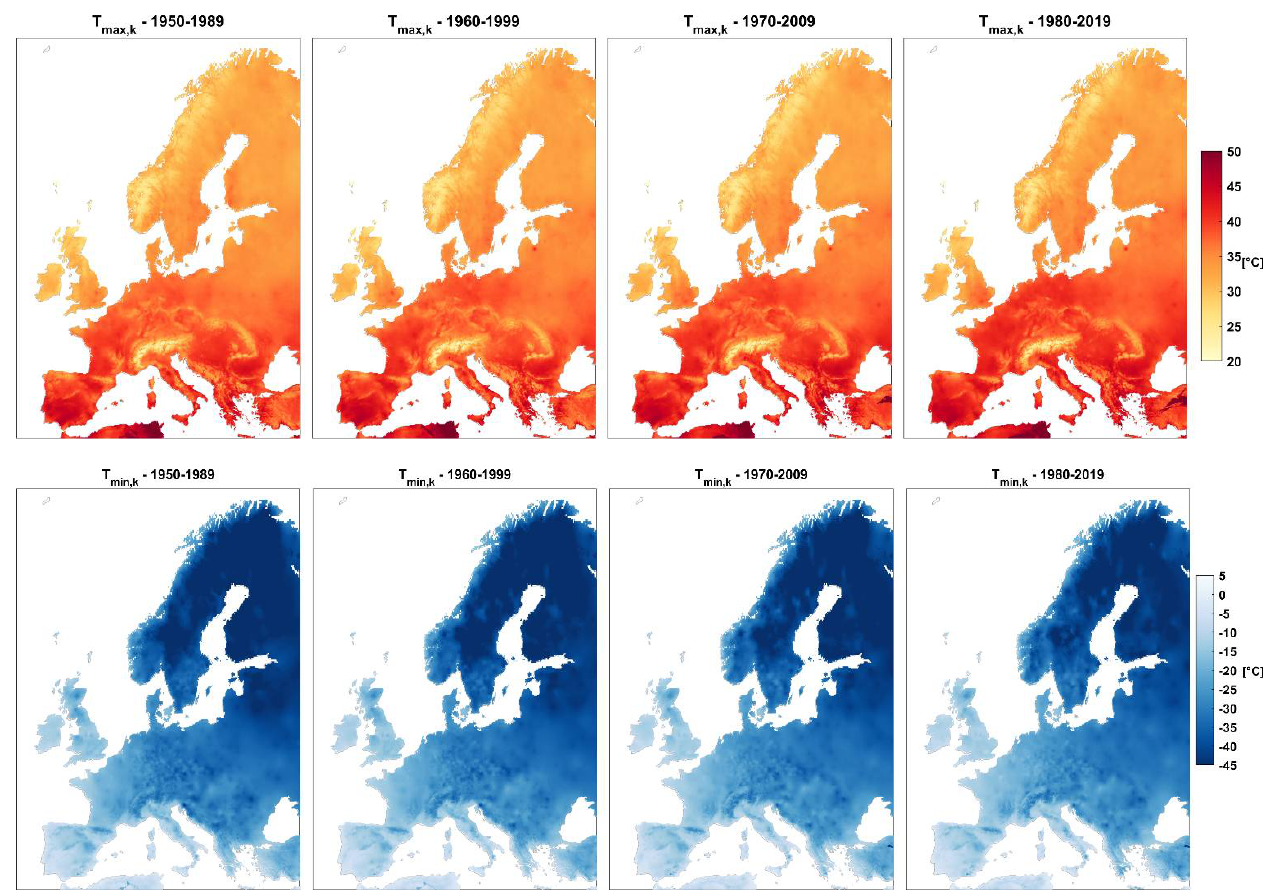
Figure 6. Maps of characteristic values of daily temperatures T max and T min , based on the E-OBS dataset in moving time windows (1950–1989, 1960 – 1999, 1970 – 2009 and 1980–2019).